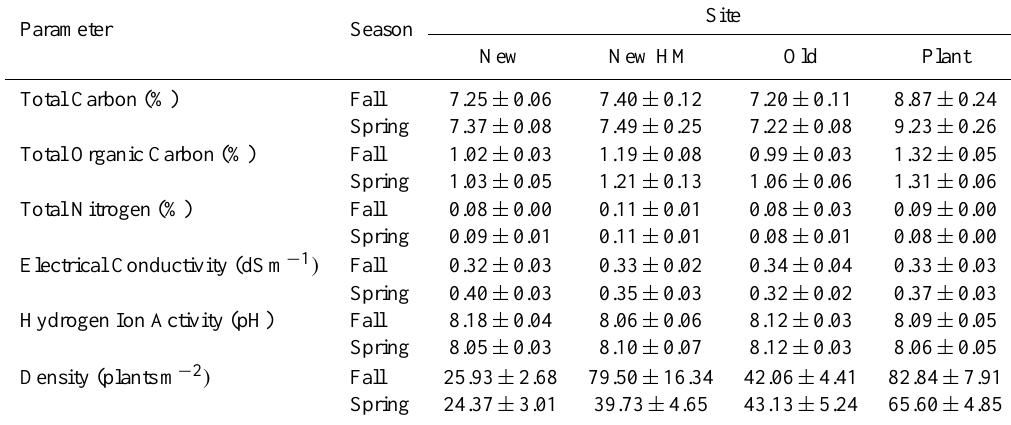
Table 3. Mean measured soil properties and seeded plant density in fall and spring treatments in 2009.